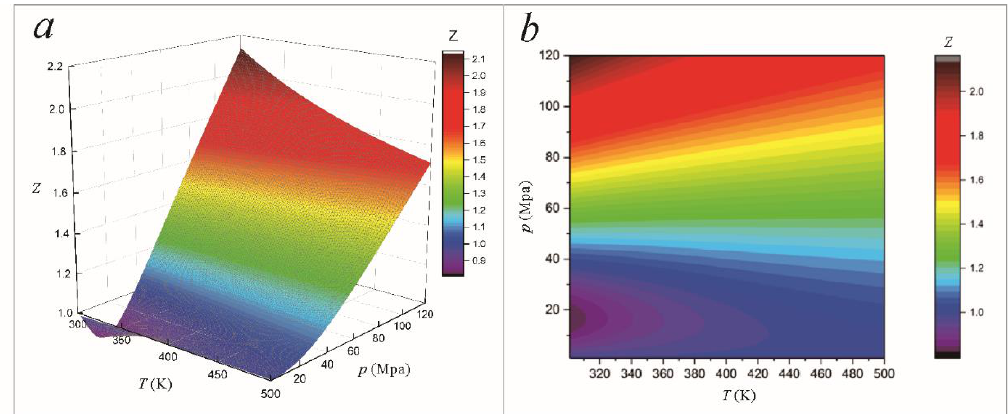
Figure 13. Three-dimensional distribution ( a ) and plane contour ( b ) of the methane compression factor ( Z ) in the ranges of the reservoir temperature and pressure (Equation (6)). Generally, the compression factor increases with the reservoir temperature and pressure.